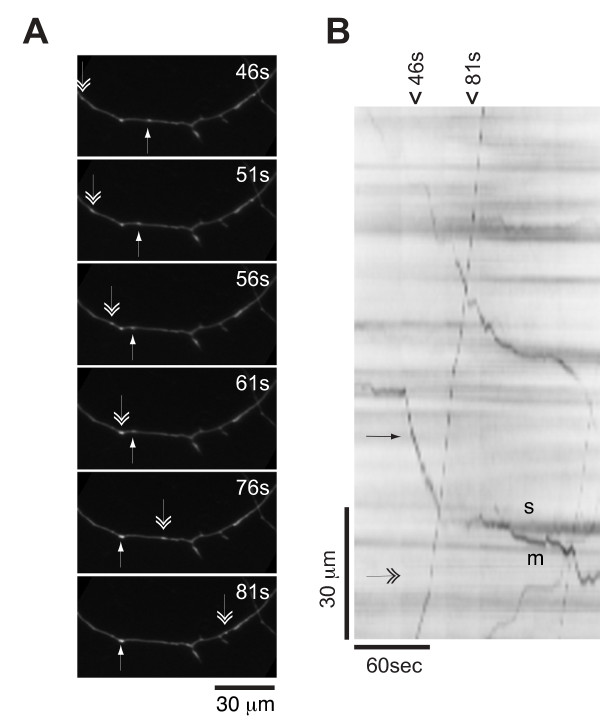
ASGFP transport behavior. (A) Time lapse fluorescent images of ASGFP transport particles in rat primary hippocampal neurons visualized at 10 DIV. The single-headed arrow indicates an ASGFP structure that moves along the axon, while the double-headed arrow indicates an ASGFP structure moving in the opposite direction. (B) Kymograph of the full time lapse series, with the time window depicted in A noted on top (46-81s). The particles are labeled as in panel A. One of the particles (double-headed arrow) is seen to move continuously in one direction, while other particle (single-headed arrow) moves in the opposite direction, pauses, and then bifurcates into stationary (s) and motile (m) particles.